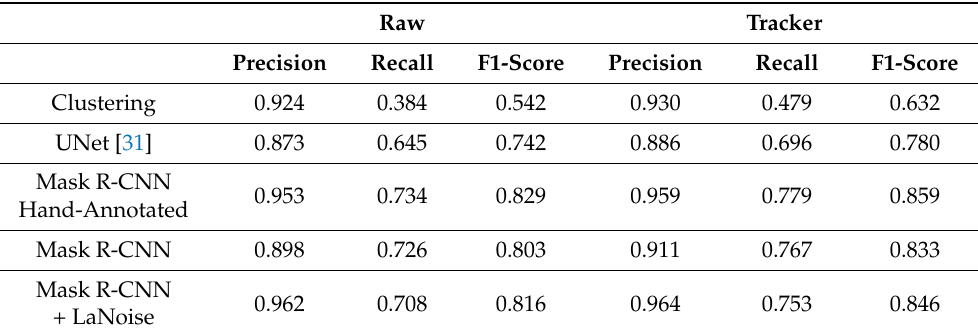
Table 2. Comparison of the results of the methods across the good weather dataset. The proposed method, the auto-labelled Mask R-CNN + LaNoise, performed comparatively well to the hand- annotated Mask R-CNN but ahead of the auto-labelled Mask R-CNN. Raw Tracker Precision Recall F1-Score Precision Recall F1-Score Clustering 0.924 0.384 0.542 0.930 0.479 0.632 UNet [31] 0.873 0.645 0.742 0.886 0.696 0.780 Mask R-CNN 0.953 0.734 0.829 0.959 0.779 0.859 Hand-Annotated Mask R-CNN 0.898 0.726 Mask R-CNN 0.962 0.708 0.816 + LaNoise